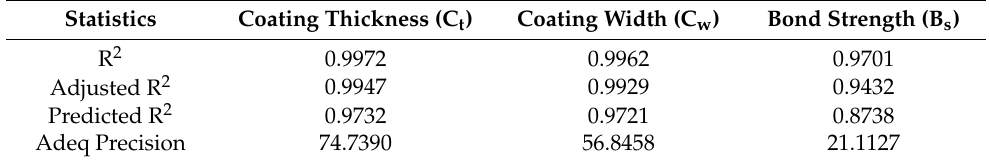
Table 9. Regression statistics for coating thickness (C t ), coating width (C w ), and bond strength (B s ).